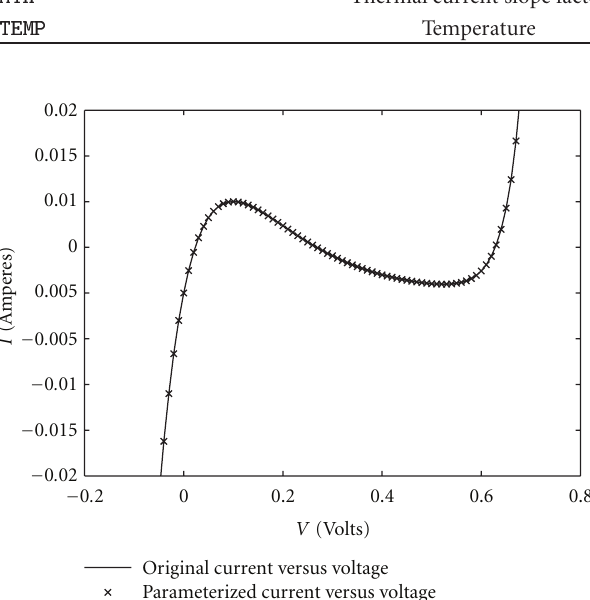
Figure 7: Esaki tunnel diode voltage with respect to state